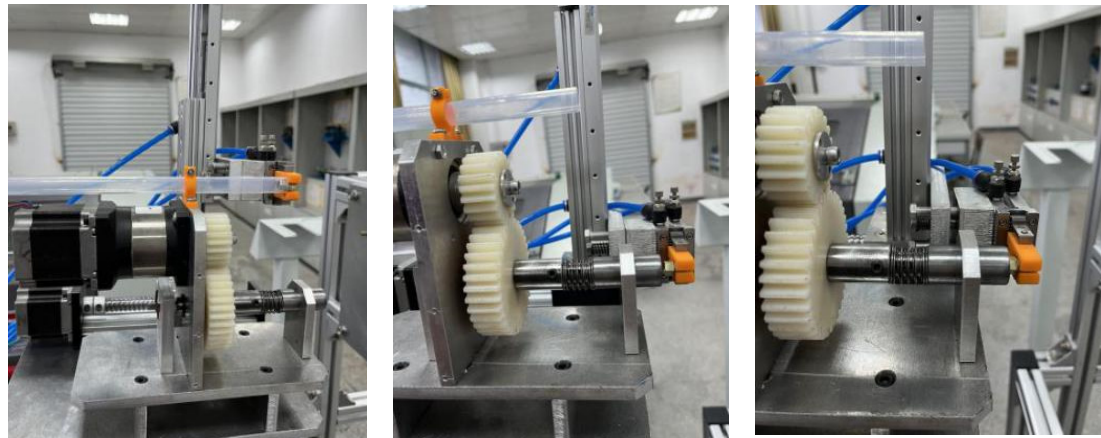
Figure 17. Feeding and aligning of hi-lok nut.